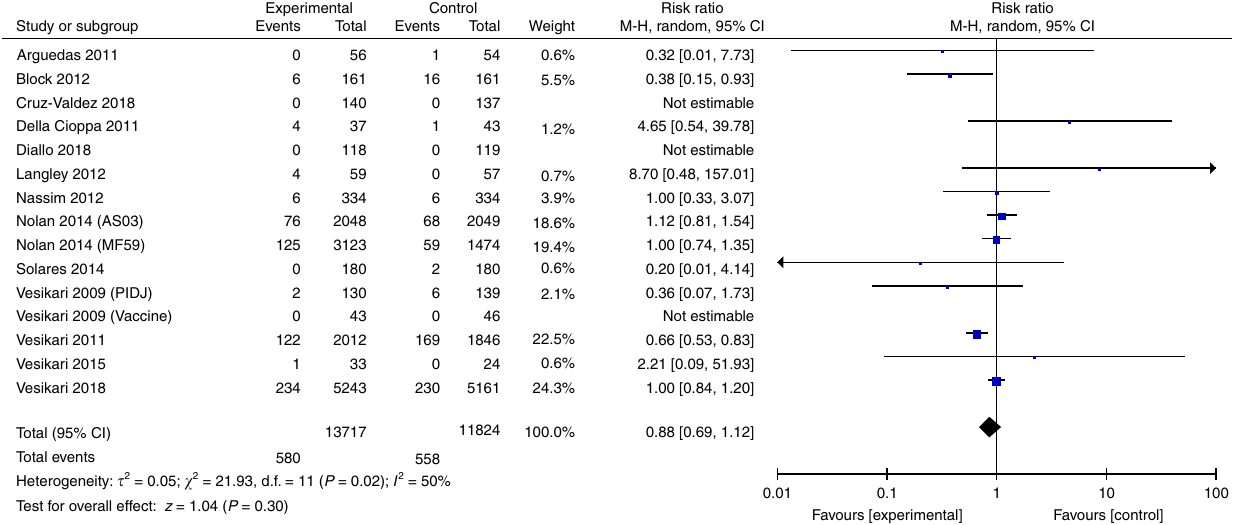
Fig. 9 Forest plot showing the risk ratios of serious adverse events during the follow-up time (ranging from 21 to 390 days) after the vaccinations among